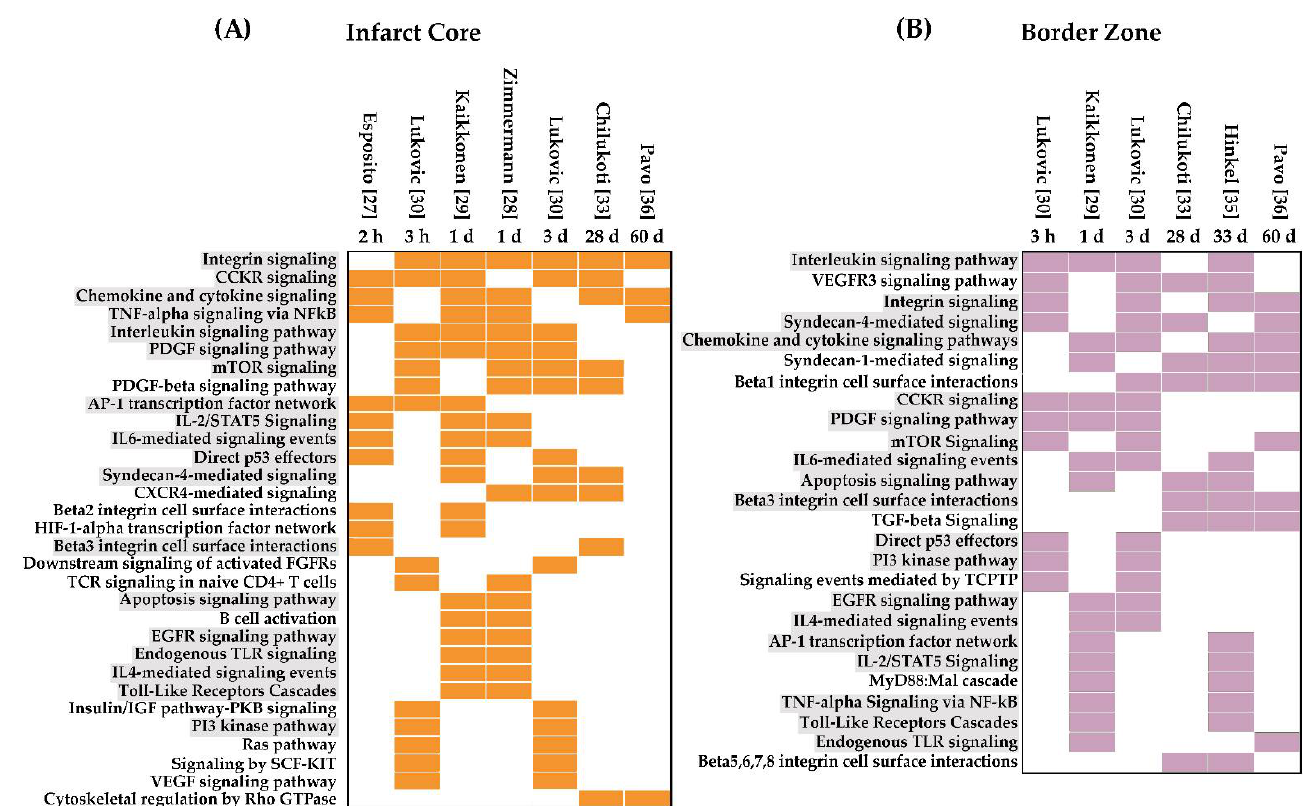
Figure 2. Active Signaling Pathways (SPs) in the Infarct Core ( A ) and the Border Zone ( B ). For each histological area, upregulated genes registered in the published data sets were analyzed separately using Enrichr and g: Profiler to identify active SPs. Only results with significant adjusted p -values (<0.05) were considered as active in the tissues corresponding to each data set. Identified active SPs in at least two data sets were defined as active in this comprehensive IRI analysis. Active SPs were ordered chronologically. Colored boxes indicate the active SPs. Active SPs common to the Infarct Core and the Border Zone are highlighted in grey. Listed Active SPs from each histological area were compared to identify similarities using a Venn diagram (not shown).